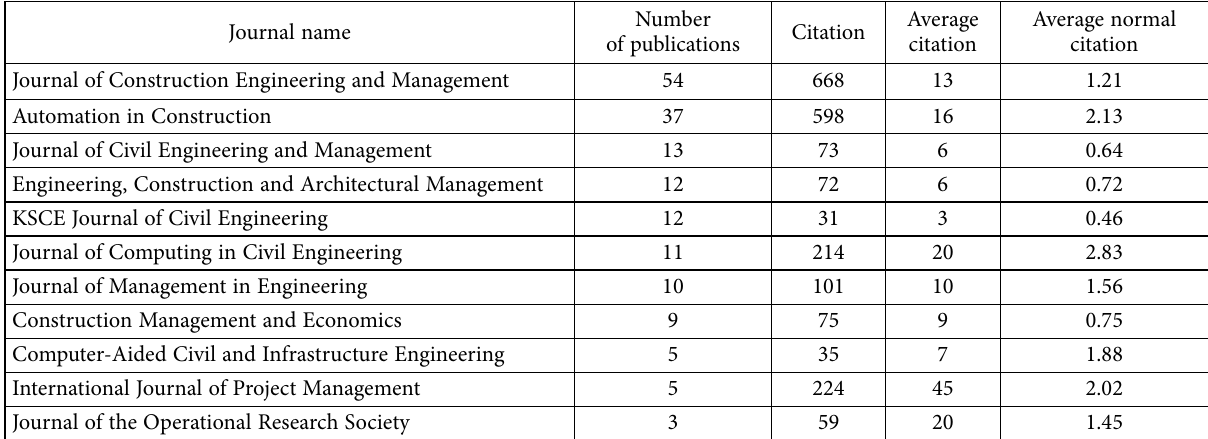
Table 2. Summary of measurements of journals publishing CPS